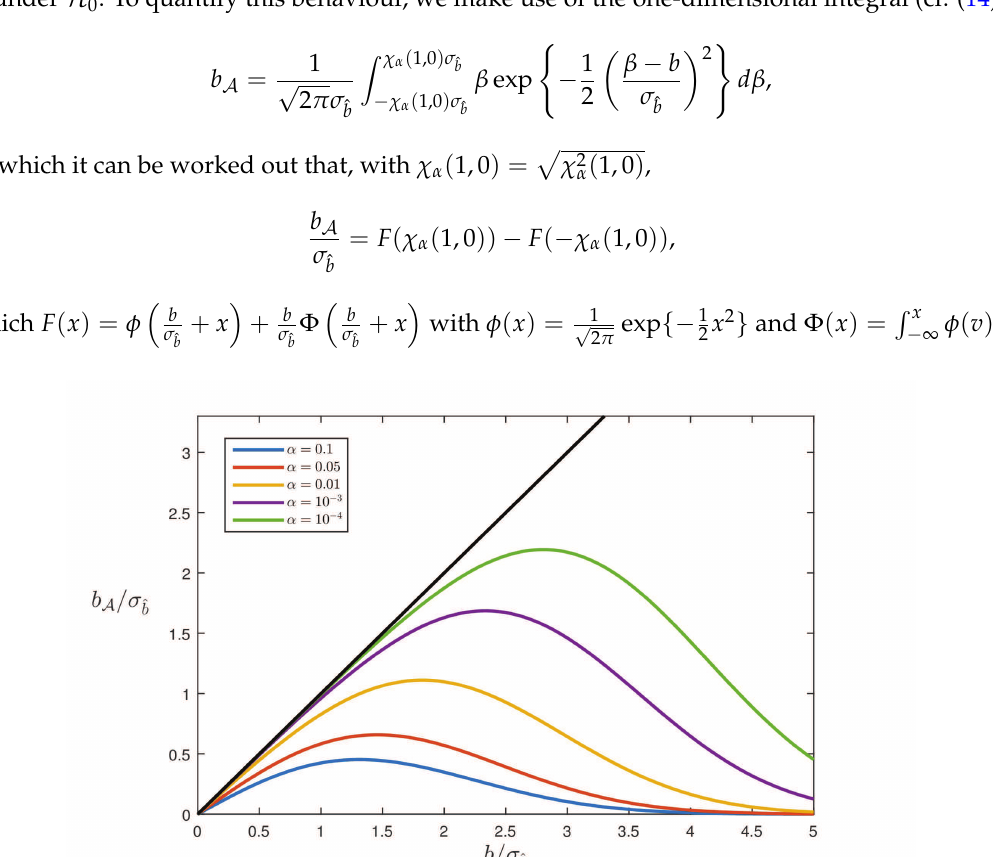
Figure 3. Bias b A / σ ˆ